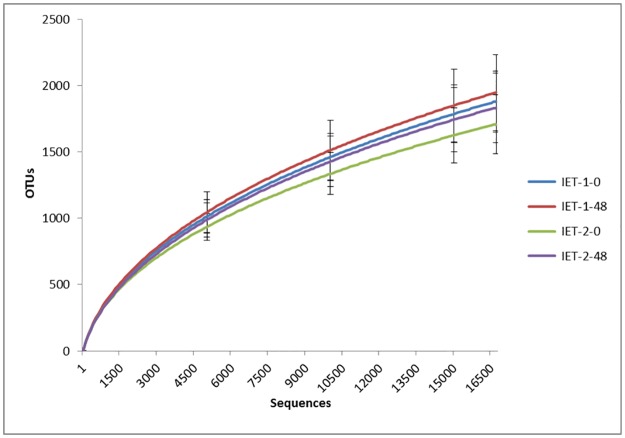
Mean values and standard deviations of rarefaction curves comparing the number of sequences and OTUs found in the DNA of fillies’ stool.Groups: IET-1-0: immediately before the first incremental test (blue); IET-1-48: 48 h after the first incremental test (red); IET-2-0: immediately before the second incremental test (green); IET-2-48: 48 h after the second incremental test (purple).